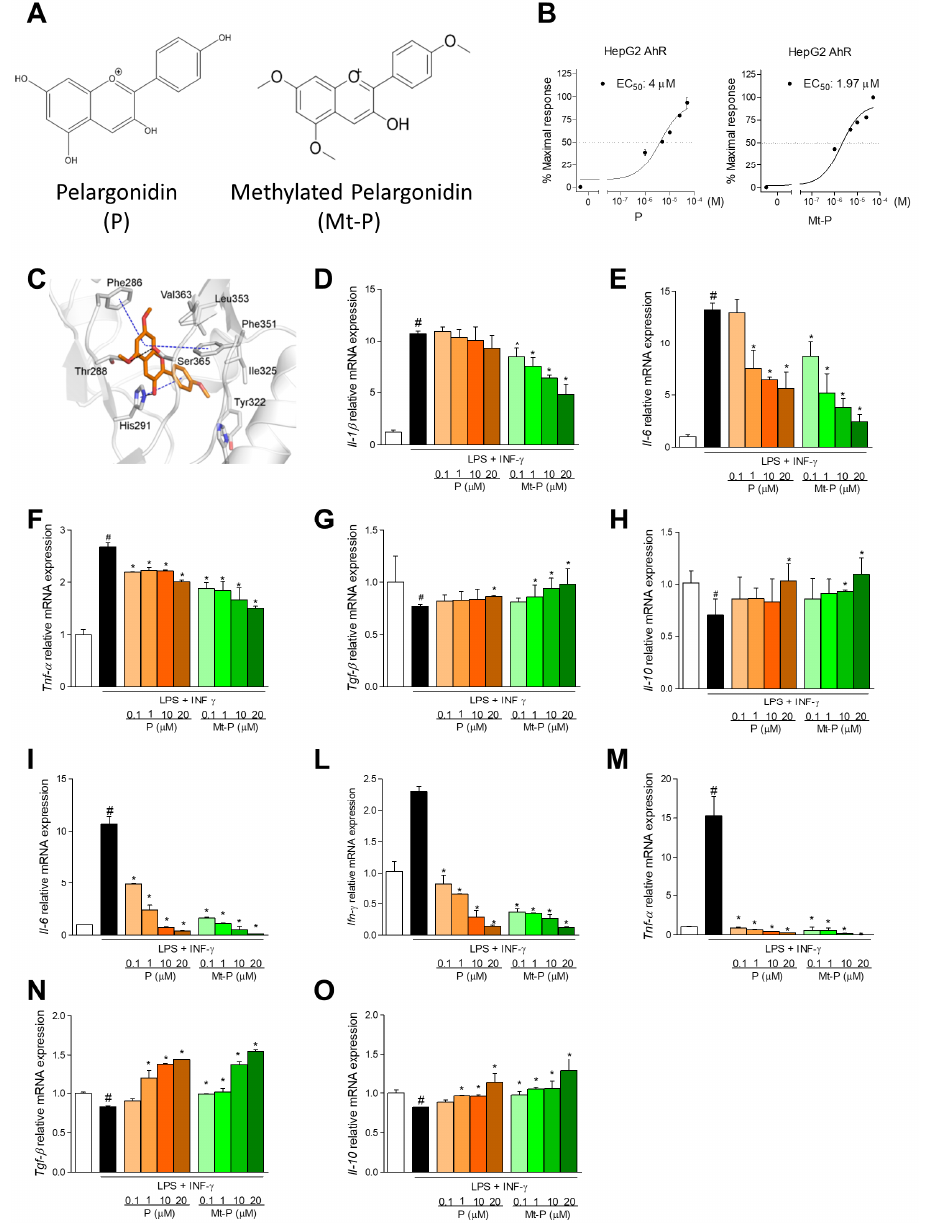
Figure 1. P and Mt-P counteracts in vitro macrophages and T-cells immune activation. The experiment was carried out on HepG2, Raw264.7 or EL4 cell lines. ( A ) Molecular structure of P and Mt-P. ( B ) Concentration-response curves of P and Mt-P on the aryl hydrocarbon receptor (AhR). HepG2 cells were transiently transfected as described in the Section 2. 24 h post-transfection cells were stimulated with increasing concentrations of P or Mt-P (1–50 µM). TCDD was used as a positive control. ( C ) Binding model of the Mt-P (orange sticks) into the PAS B domain of the AhR (white cartoon and sticks). Highlighted with dashed black line is the h-bond interaction with His291 and Ser 365, while with dashed blue line is the aromatic interaction. ( D – H ) In vitro e ff ects of P and Mt-P on murine macrophages activation. Relative mRNA expression of pro- and anti-inflammatory genes was assessed by Real-Time PCR in Raw246.7 cells: ( D ) Il-1 β , ( E ) Il-6 , ( F ) Tnf- α , ( G ) Tgf- β , and ( H ) Il-10 relative mRNA expression. ( I – O ) In vitro e ff ects of P and Mt-P on murine T-cells activation. Relative mRNA expression of pro- and anti-inflammatory genes was assessed by Real-Time PCR in EL4 cells: ( I ) Il-6 , ( L ) Ifn- γ , ( M ) Tnf- α , ( N ) Tgf- β , and ( O ) Il-10 . Values are normalized relative to Gapdh mRNA and are expressed as mean ± SEM ( n = 3); # p < 0.05 vs. NT cells, * p < 0.05 vs. LPS / IFN- γ